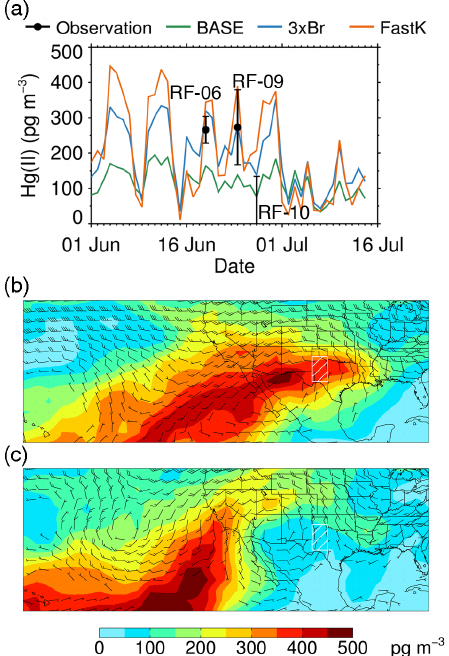
Figure 11. (a) Modeled time series of midday (noon–3p . m . ) Hg(II) concentrations at 6.5km altitude over Texas (white rectangle shown in panels b, c ) for the three GEOS-Chem simulations (BASE: green, 3 × Br: blue, FastK: orange) for 1 June–15 July 2013 and the mean and standard deviations of Hg(II) observations at 6–7km over Texas for RF-06, RF-09 and RF-10. (b) Mean midday FastK Hg(II) con- centrations and winds at 6.5km altitude for the 10 highest FastK Hg(II) concentrations from the time series in panel (a) . (c) Mean midday FastK Hg(II) concentrations for the 10days with the lowest Hg(II)